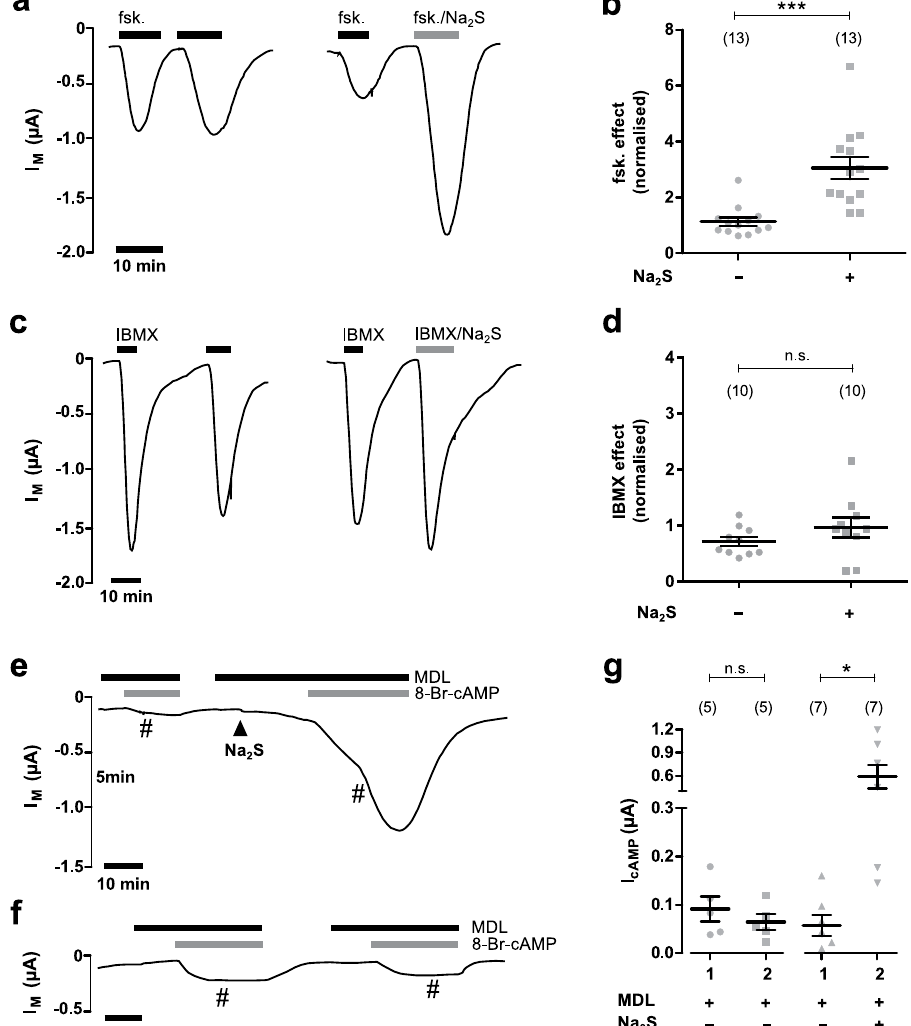
Figure 4. H 2 S targets phosphodiesterase rather than adenylyl cyclase. ( a ) Representative current traces of TEVC recordings of CFTR-expressing oocytes. Transmembrane currents (I M ) were recorded and oocytes were either exposed twice to forskolin (fsk., 5 µ M; black bars; left trace) or first to forskolin and then to a combination of forskolin and 50 µ M Na 2 S (grey bar; right trace). ( b ) Statistical analysis of data obtained from experiments as shown in panel a. Depicted are normalised values from individual experiments (grey symbols) as well as means ± SEM of forskolin (fsk.) effects. This represents the ratio of the first and second current stimulated by forskolin ( *** P ≤ 0.001, Mann-Whitney test). ( c ) Representative current traces of TEVC recordings of CFTR- expressing oocytes. Oocytes were either exposed twice to IBMX (1 mM; black bars; left trace) or first to IBMX and then to a combination of IBMX and 50 µ M Na 2 S (grey bar; right trace). ( d ) Statistical analysis of data obtained from experiments as shown in panel c. Depicted are normalised values from individual experiments (grey symbols) as well as means ± SEM of IBMX effects. This represents the ratio of the first and second current stimulated by IBMX Student’s unpaired t-test with Welch’s correction). ( e, f ) Representative current traces of TEVC recordings of CFTR-expressing oocytes. ( f ) Oocytes were exposed twice to membrane-permeable 8Br- cAMP (100 µ M, grey bars) in the presence of the AC-inhibitor MDL 12330 A (MDL, 20 µ M; black bars). The perfusion was stopped (indicated by the number symbol’) when 8-Br-cAMP was in the perfusion chambers in order to avoid massive consumption of this compound. Perfusion was started again at the time of drug removal. ( e ) The same protocol was employed, with the exception that Na 2 S (50 µ M, black arrowhead) was applied before the second exposure to 8Br-cAMP. ( g ) Statistical analysis of data obtained from experiments as shown in panels e and f. Depicted are values of the first (1) and second (2) 8-Br-cAMP-induced current (I cAMP ) from individual experiments (grey symbols) as well as means ± SEM ( ** P ≤ 0.01, Student’s paired t-test). Numbers of experiments (n) are indicated in